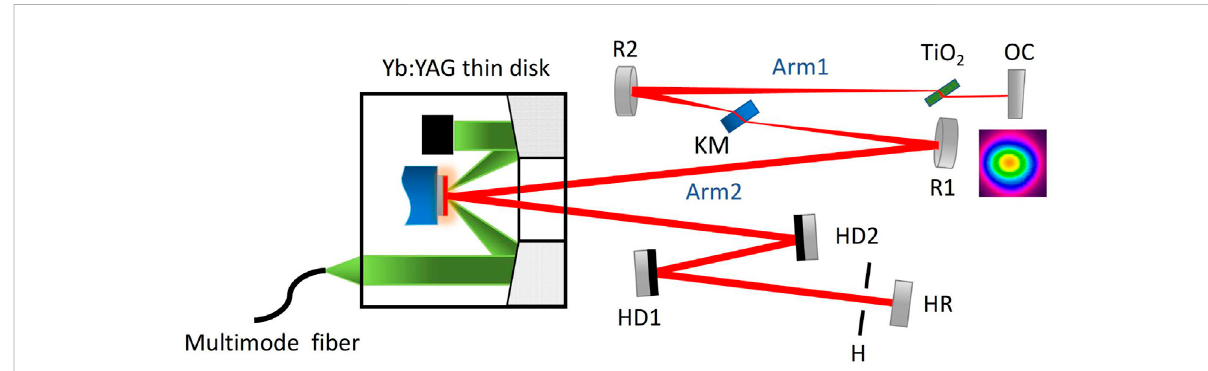
FIGURE 1 Schematic of the Yb:YAG thin-disk oscillator. The Yb:YAG thin disk is wedged with a ROC of − 20 m. HR, high-re fl ection mirror; HD, high- dispersion mirrors; OC, output coupler; KM, Kerr medium (sapphire plate); H, hard aperture; R1 and R2, concave mirrors with ROC of − 150 and − 50 mm,